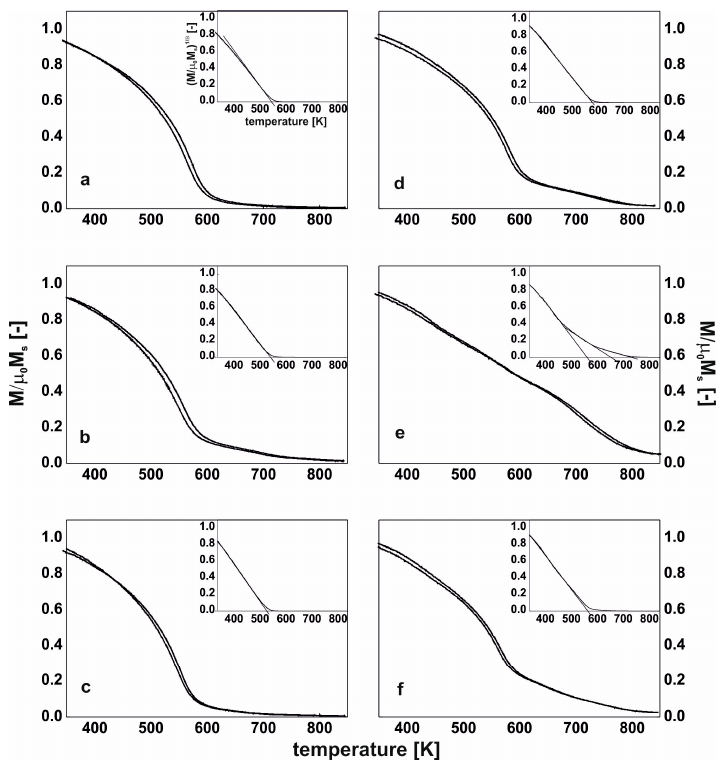
Figure 5. The magnetic saturation polarization curves for the alloys in the as-cast state ( a – c ) and after the thermal treatment at 940 K for 10 min ( d – f ) made by the injection-casting method: Fe 61 Co 10 W 1 Y 8 B 20 ( a , d ), Fe 62 Co 9 W 1 Y 8 B 20 ( b , e ), Fe 63 Co 8 W 1 Y 8 B 20 ( c , f